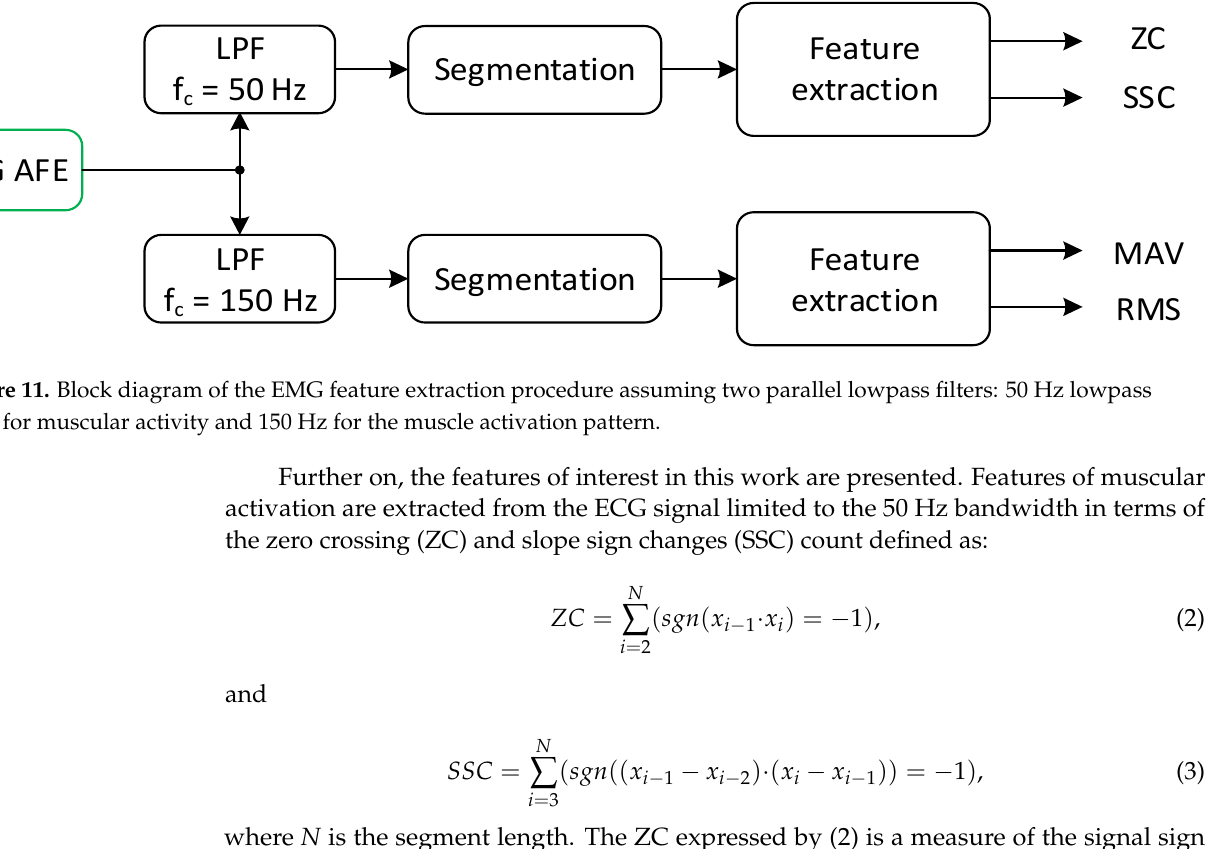
Figure 10. Electrode placement for lower-limb EMG acquisition of the ( a ) tibialis anterior, ( b ) gastrocnemius.